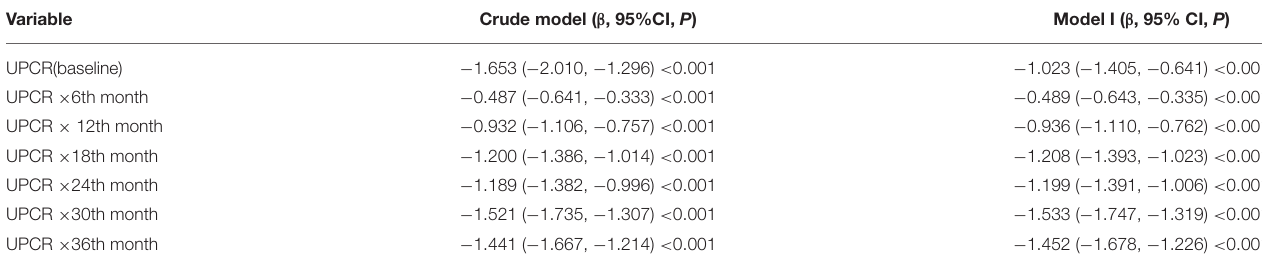
TABLE 7 | Relationship between baseline UPCR and longitudinal eGFR derived from a linear mixed-effects regression